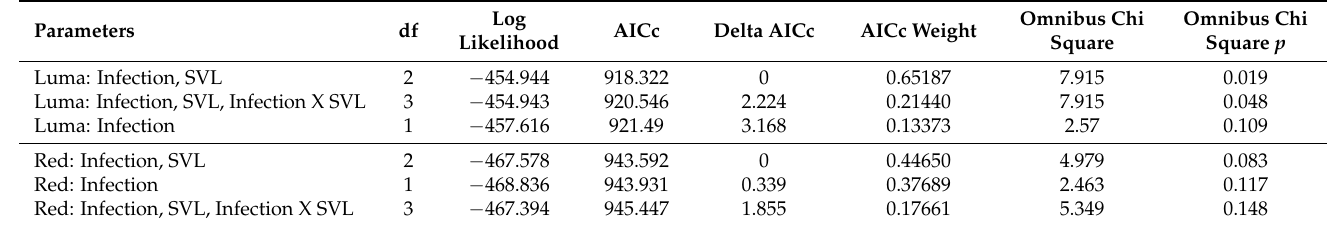
Table 1. Results of models considered with luma and chroma as the dependent variables in two separate tests. The models explain the likelihood of dewlap color in Anolis sagrei individuals in Florida, USA, with regard to infection by Plasmodium floridense and body length (SVL).